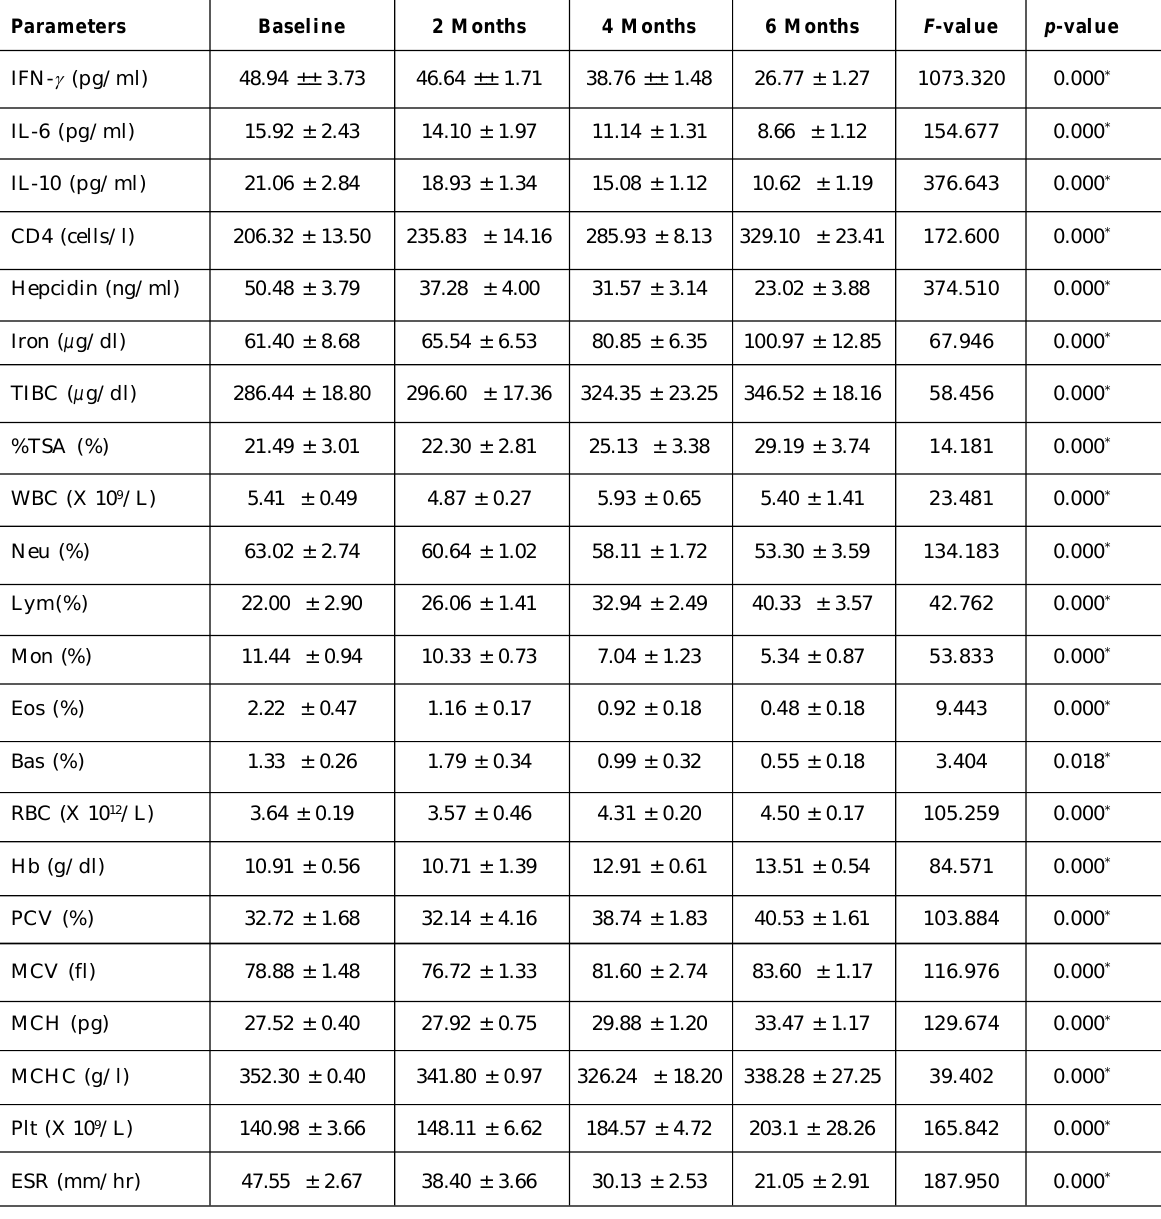
Table 1: Mean ± SD values of interferon-gamma, IL-6, IL-10, CD4, hepcidin, iron, and some hematological parameters of PTB subjects based on duration of